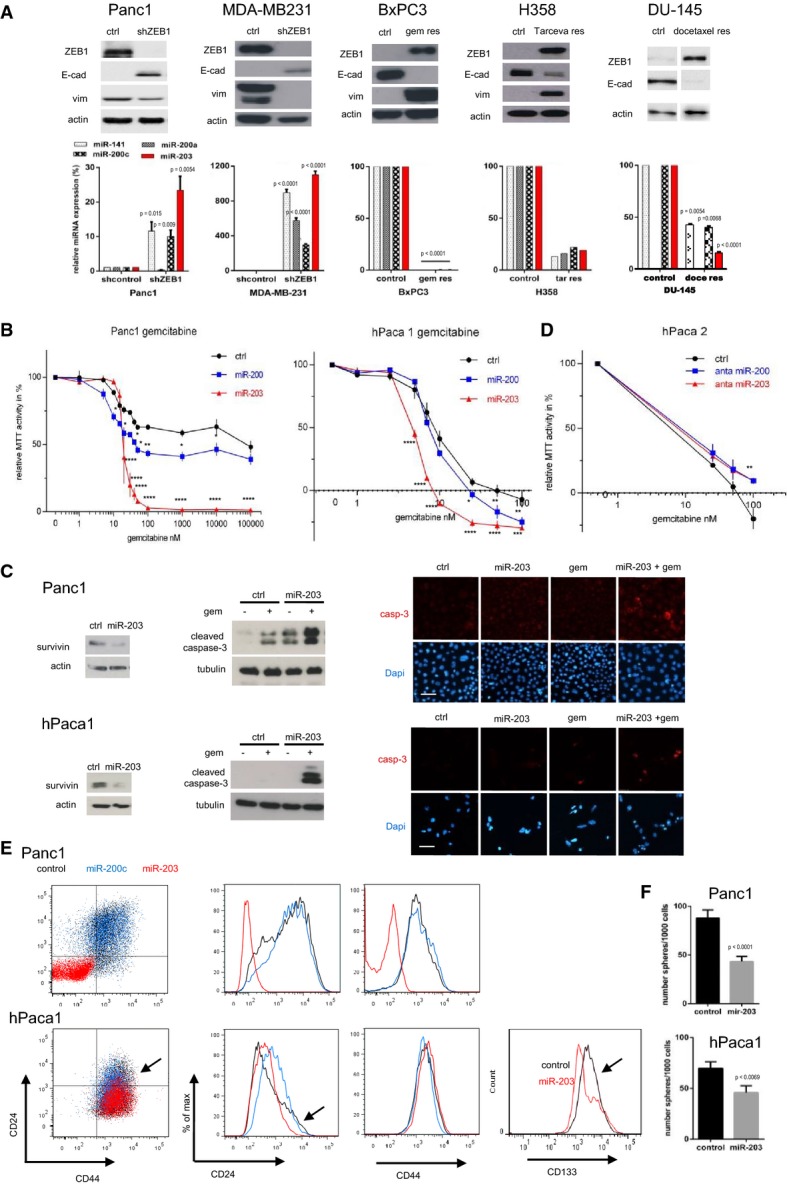
miR-203 restores drug sensitivity

Immunoblots and qRT–PCRs showing that expression levels of miR-203, miR-200, and E-cadherin are increased after ZEB1 knockdown in Panc1, MDA-MB-231. Vice versa, the drug-resistant clones of BxPC3, H358, and DU-145 show increased expression of ZEB1 and decreased expression of the miRNAs and E-cadherin. n = 3, mean ± SEM, except for H358 (data from microarray). Unpaired Student's t-test.

Lentiviral overexpression of miR-200c and miR-203 in Panc1 and hPaca1 induces sensitivity to gemcitabine treatment as measured by MTT assay. For the changes in EC50 values, see Table1. n = 3, mean ± SEM, Dunnett's multiple comparisons test (P-values in the graphs are *P = 0.01–0.05, **P = 0.001–0.01, ***P < 0.001, and ****P < 0.0001; for exact P-values, see Supplementary Table S4).

Overexpression of miR-203 decreases expression of the anti-apoptotic factor survivin and sensitizes to gemcitabine-triggered apoptosis as evaluated by cleaved caspase-3 in Western blot and immunofluorescence. Panc1 and hPaca1 were treated with 50 and 5 nM gemcitabine, respectively, for 48 h. Scale bar 20 μm.

MTT assay showing increase in gemcitabine resistance after inhibition of endogenous miRNAs in hPaca2 by specific antagomirs against miR-203 or all miR-200 members. For the changes in EC80 values, see Table1. n = 3, mean ± SEM, Dunnett's multiple comparisons test (P-values in the graphs are *P = 0.01–0.05, **P = 0.001–0.01, ***P < 0.001, and ****P < 0.0001; for exact P-values, see Supplementary Table S4).

Overexpression of miR-203 shows reduced numbers of the CD24/CD44 double-positive cancer stem cell population as determined by FACS analysis. The arrow indicates the reduction in the CD24 high subpopulation and reduction in CD133 by miR-203 overexpression in hPaca1 cells.

Cancer stem cell sphere assay showing reduced sphere-forming capacity of Panc1 and hPaca1 in miR-203 overexpression cells. Colonies with a diameter greater than 75 μM for Panc1 and greater 30 μM for hPaca1 cells were counted as spheres. n = 3, mean ± SEM, Mann–Whitney U-test.

Source data are available online for this figure.